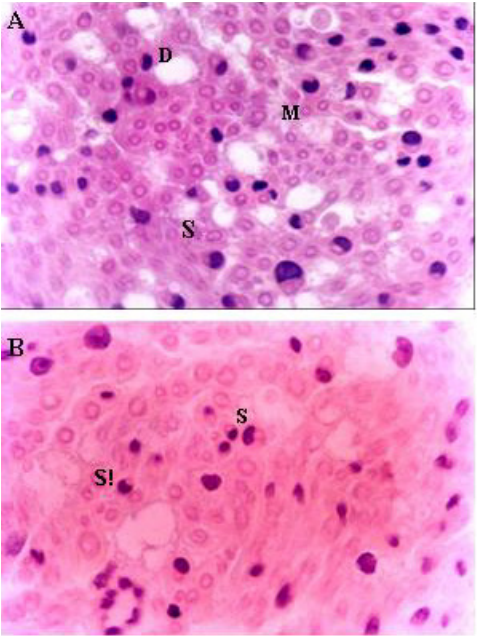
FIGURE 2 – Photomicrograph of the sciatic nerve of the rat in cross-section in the control group (origi- nal magnification 100X.). A: D – Wallerian Degen- eration / M – Macrophage / S – Schwann Cell / S!